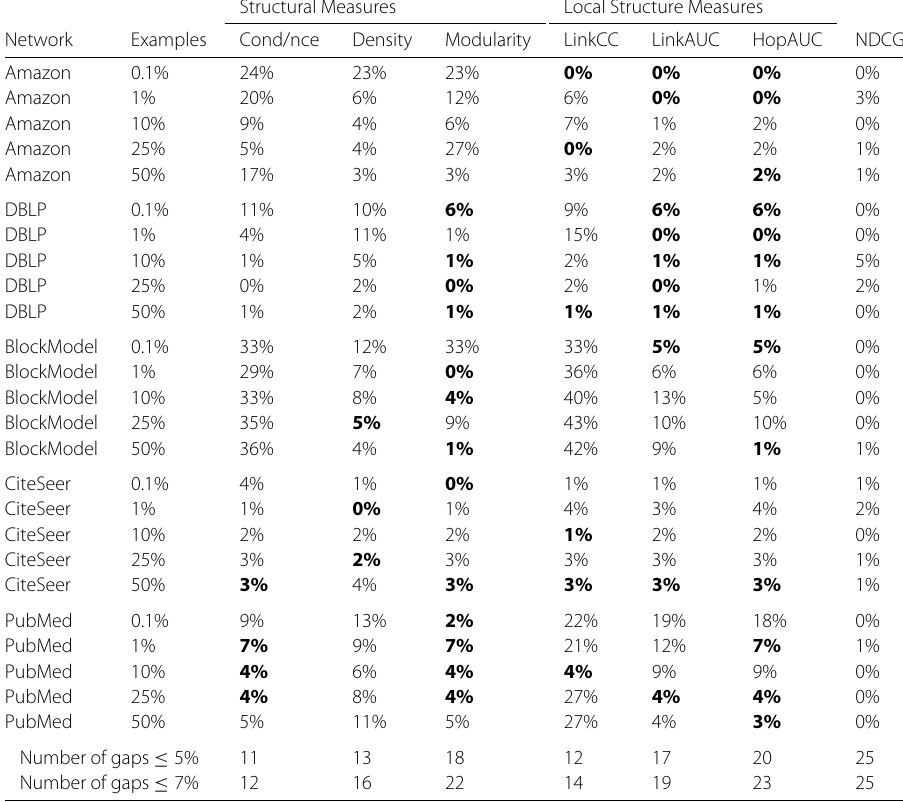
Table 5 Gap between the best AUC value and the AUC of the algorithm corresponding to the best measure value Structural Measures Local Structure Measures Network Examples Cond/nce Density Modularity LinkCC LinkAUC HopAUC NDCG Amazon 0.1% 24% 23% 23% 0% 0% 0% 0% Amazon 1% Amazon Amazon 50% 1% 4% 11% 1% 15% 0% 0% 0% DBLP 10% 1% 5% 1% 2% 5% DBLP 25% DBLP 50% 1% 2% 1% 1% 1% 1% 0% BlockModel 0.1% 33% 12% 33% 33% 5% 5% 0% BlockModel 1% 29% 7% 0% 36% 6% 6% 0% BlockModel 10% 33% 8% 4% 40% 13% 5% 0% BlockModel 25% 35% 5% 9% 43% 10% 10% 0% BlockModel 50% 36% 4% 1% CiteSeer 0.1% CiteSeer CiteSeer 10%